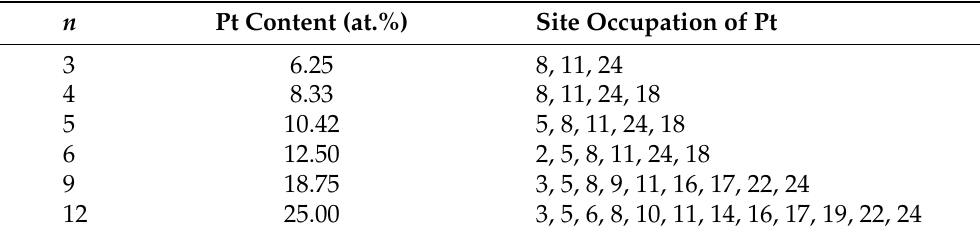
Table 1. The site preference of Pt additions in the austenite B2 3 × 2 × 2 supercell structure at different doping concentrations, n is the number of Pt atoms in the